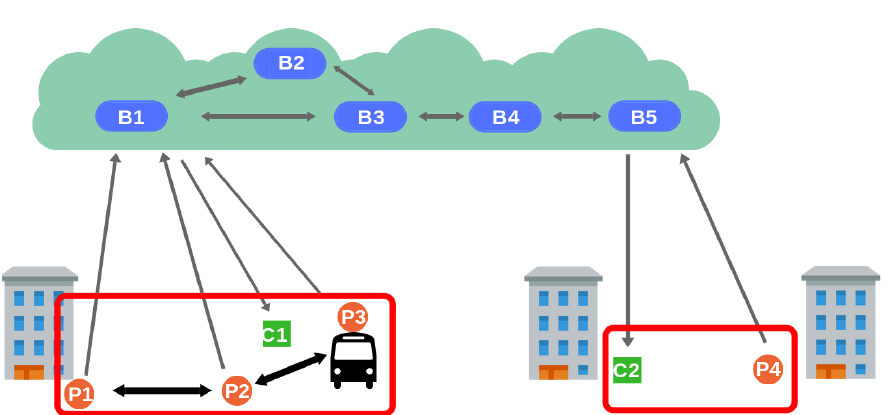
Figure 3. Assigned-brokers